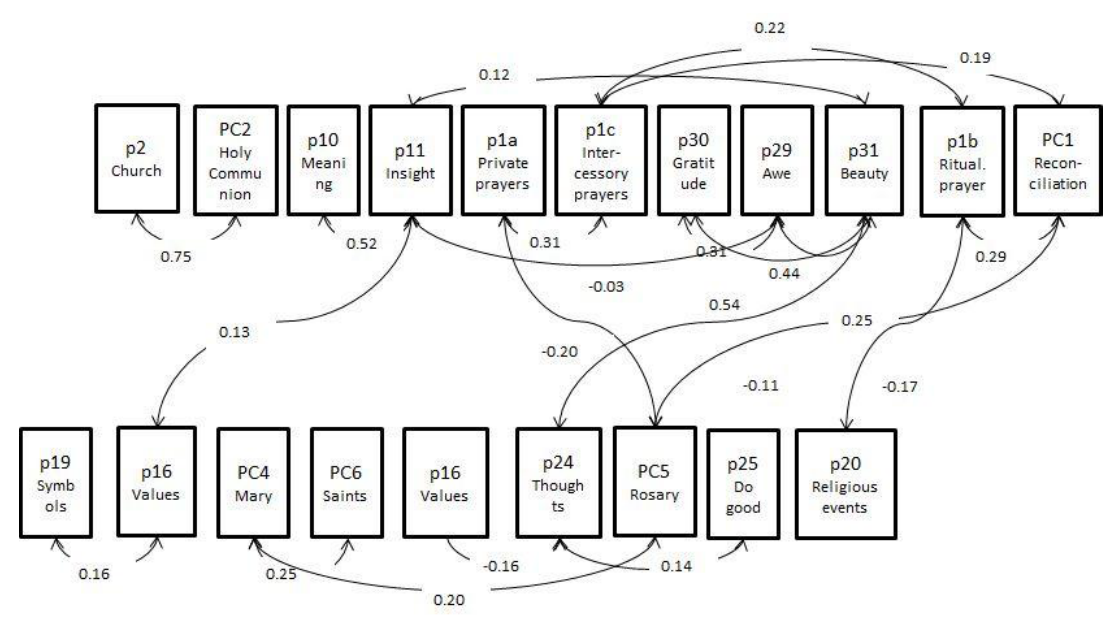
Figure 6. Correlations between variables.